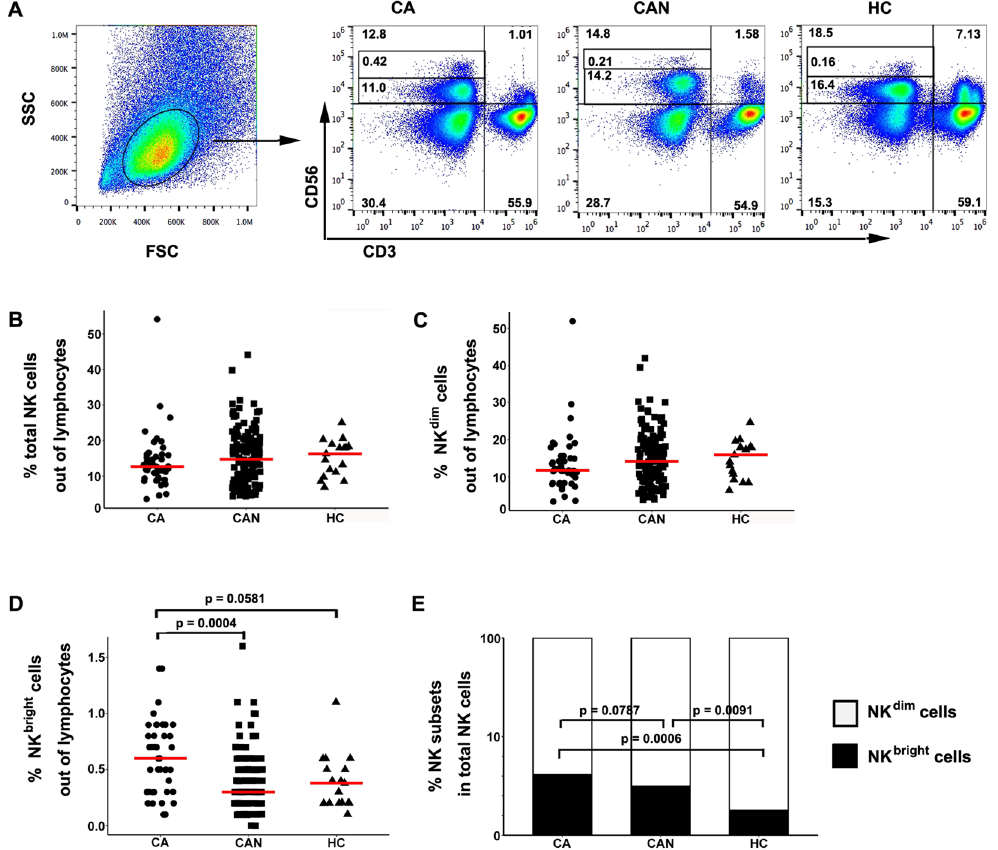
Figure 1. NK cell gating strategy and population frequency analysis in CHB patients and healthy donors. ( A ) NK cells and subsets were derived from total live PBMCs gated by forward and side scatter followed by the CD56 + CD3 − phenotype. NK dim and NK bright cells are defined by the expression of CD56 intensity. The values in the left upper quadrants represent the percentages of total NK, NK dim and NK bright cells among total lymphocytes. The data shown are representative of at least ten individuals from more than three independent experiments. ( B–D ) The frequency of total NK, NK dim and NK bright cells in CHB patient groups. Values are displayed as a percentage of NK cells and subsets among total lymphocytes. Each symbol denotes an individual subject. (E) Summary bar charts of the distribution of NK dim and NK bright subsets depicted as the frequency of total NK cells. CA, CAN: CHB patients who are within or beyond current treatment guidelines,